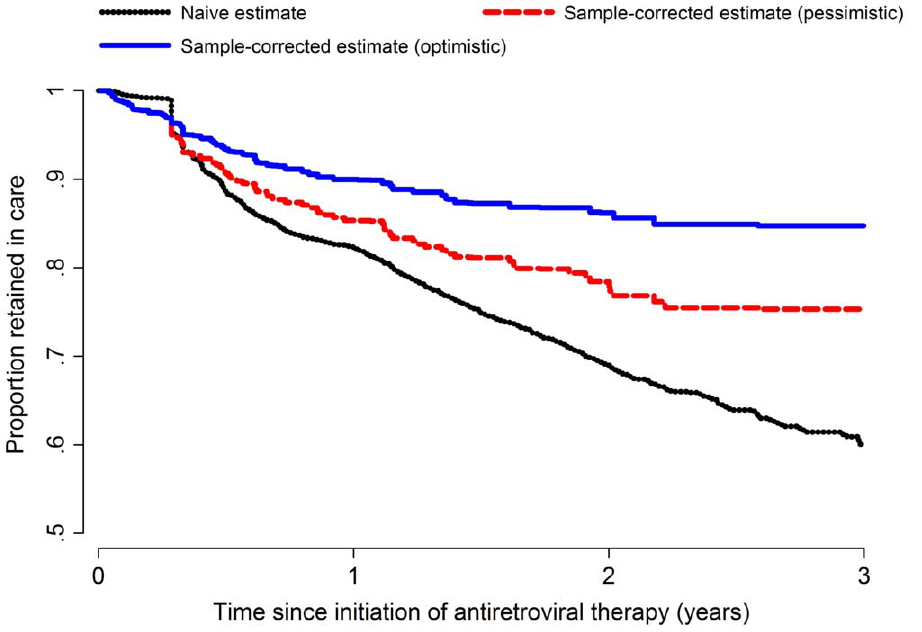
Figure 1. Naı¨ve and corrected plots of ‘‘retention in care.’’ Retention in care is defined as the fraction of patients who remain alive and in HIV care. The naı¨ve estimate assumes that all patients who are lost to follow-up from the ISS clinic are no longer retained in care. The corrected estimates of retention in care are based on outcomes ascertained from a sample of patients who were lost to follow-up from the ISS Clinic, sought in the community and in whom updated information about vital status and HIV care was obtained. If a tracked patient was found to be alive by report of an informant, we did not ask that informant whether the patient was still in HIV care because this could inadvertently violate the privacy of the patient. Therefore, we conducted a sensitivity analysis under two assumptions. The ‘‘pessimistic’’ corrected estimate is based on the assumption that all patients who were alive but not directly interviewed in person were no longer in HIV care. The ‘‘optimistic’’ corrected estimate was based on the assumption that all patients who were reported to be alive but not directly interviewed in person remained in HIV